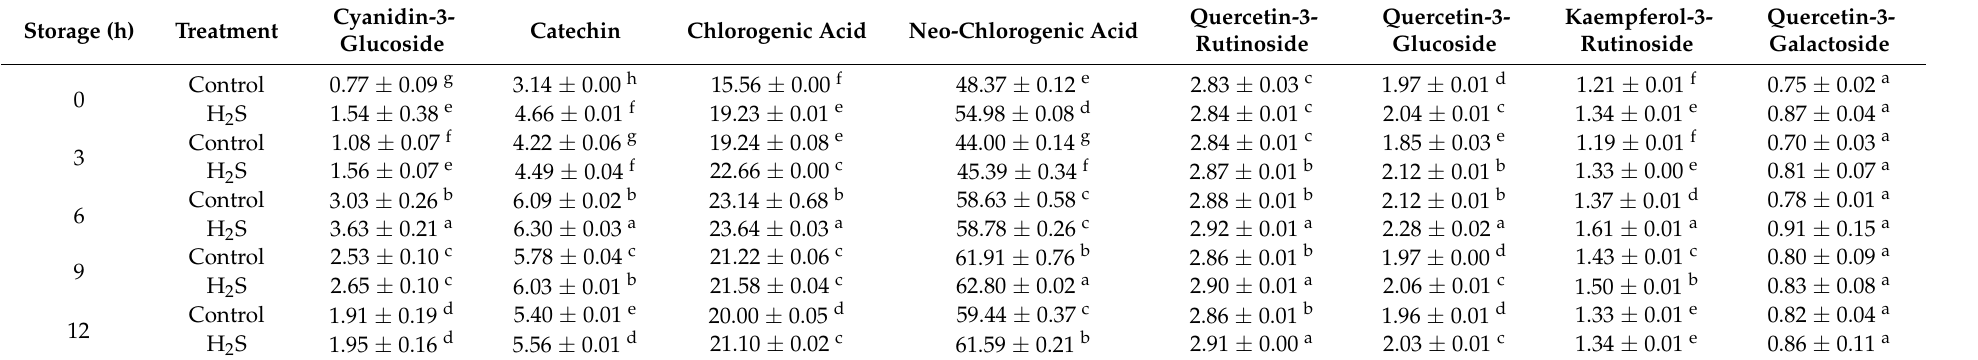
Table 2. Effects of H 2 S treatment on individual phenolic compounds in fresh-cut peaches during